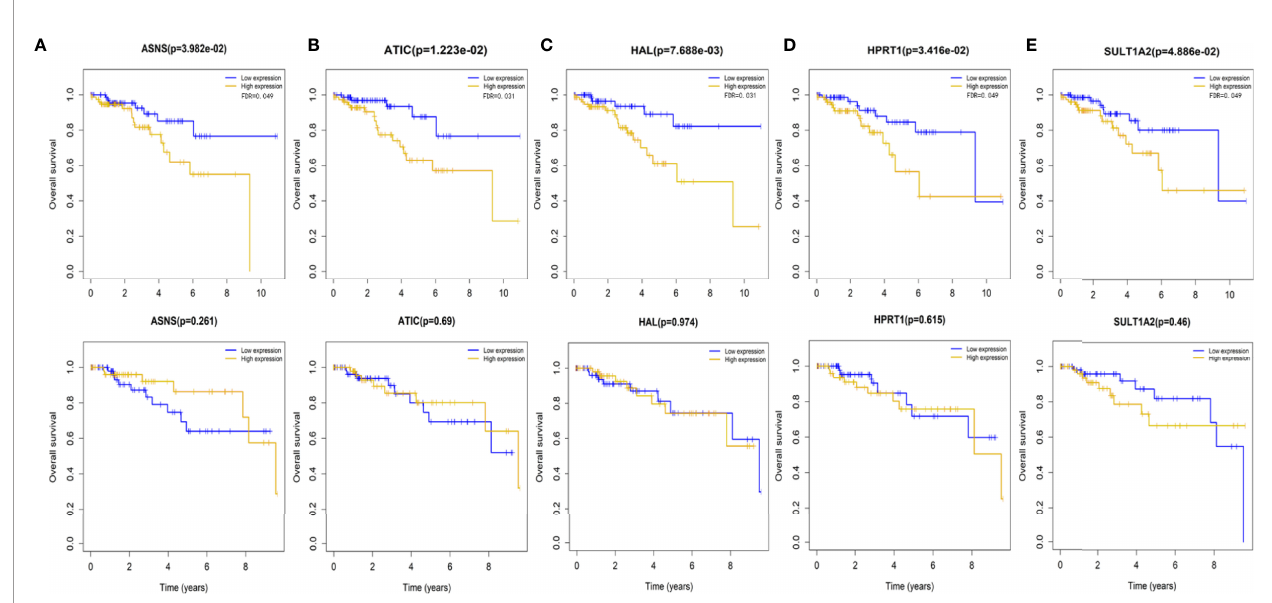
FIGURE 2 | low expression of the fi ve metabolism-related genes was associated with good survival in HER2-positive breast cancer patients, but not in triple- negative breast cancer patients. There were 156 positive cases of HER2-positive samples,114 cases of triple-negative samples. (A) ASNS (B) ATIC (C) HAL (D) HPRT1 (E)